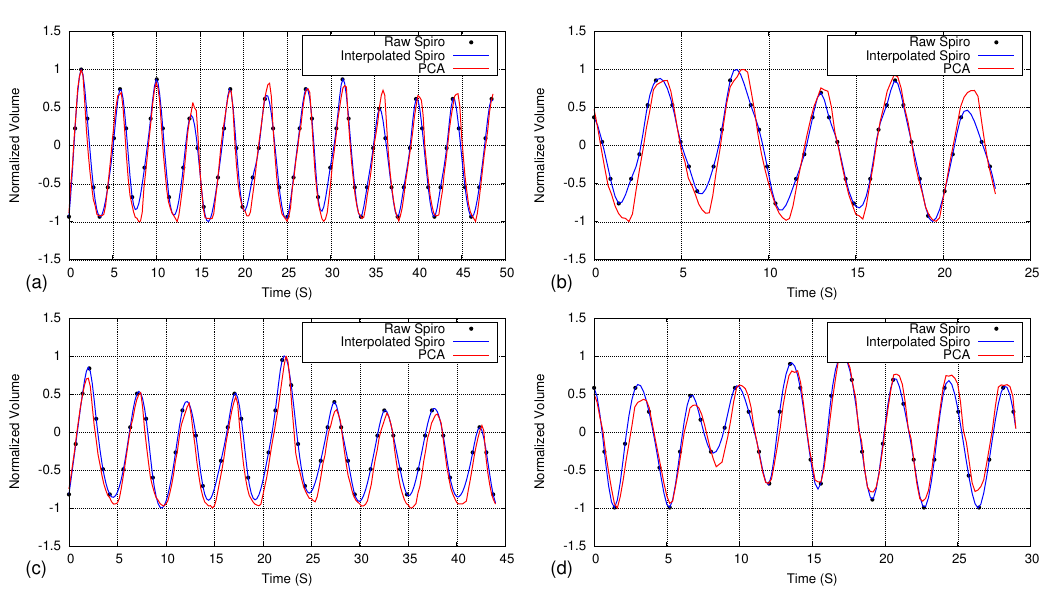
Figure 11. Comparison of respiratory volume measurement (normalized into − 1:1 range) using the proposed method (PCA) and a spirometer. Graphs ( a – d ) represent the selected four different datasets. Black dots represent the original data points of the spirometer, while the blue line represents the interpolated